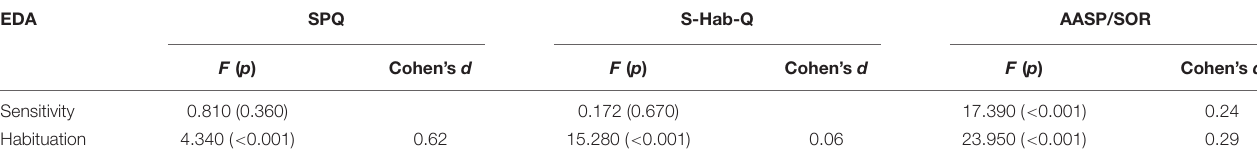
TABLE 3 | Mixed models: sensory self-report, physiological sensitivity, and habituation.